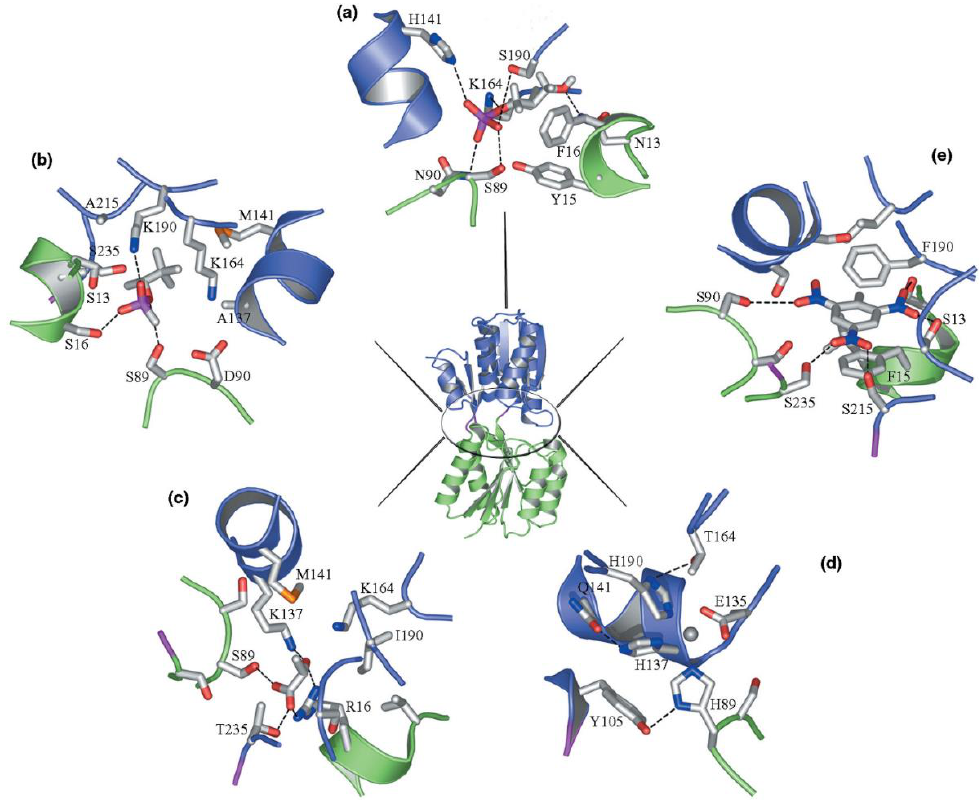
Figure 3. Diversification of ligand binding to RBP by computational design. RBP bound to ( a ) Dihy- droxyacetone phosphate (DHAP) with a Kd = 3 μM; ( b ) pinacolyl methyl phosphonic acid (PMPA), a non-toxic surrogate for the nerve agent soman, with a Kd = 70 nM; ( c ) l-lactate with a Kd = 7 μM; ( d ) Zn(II), with a Kd = 2.5 μM; ( e ) trinitrotoluene (TNT), an explosive, with a Kd = 2 nM. Reprinted with permission from [24] Copyright (2022) Elsevier.